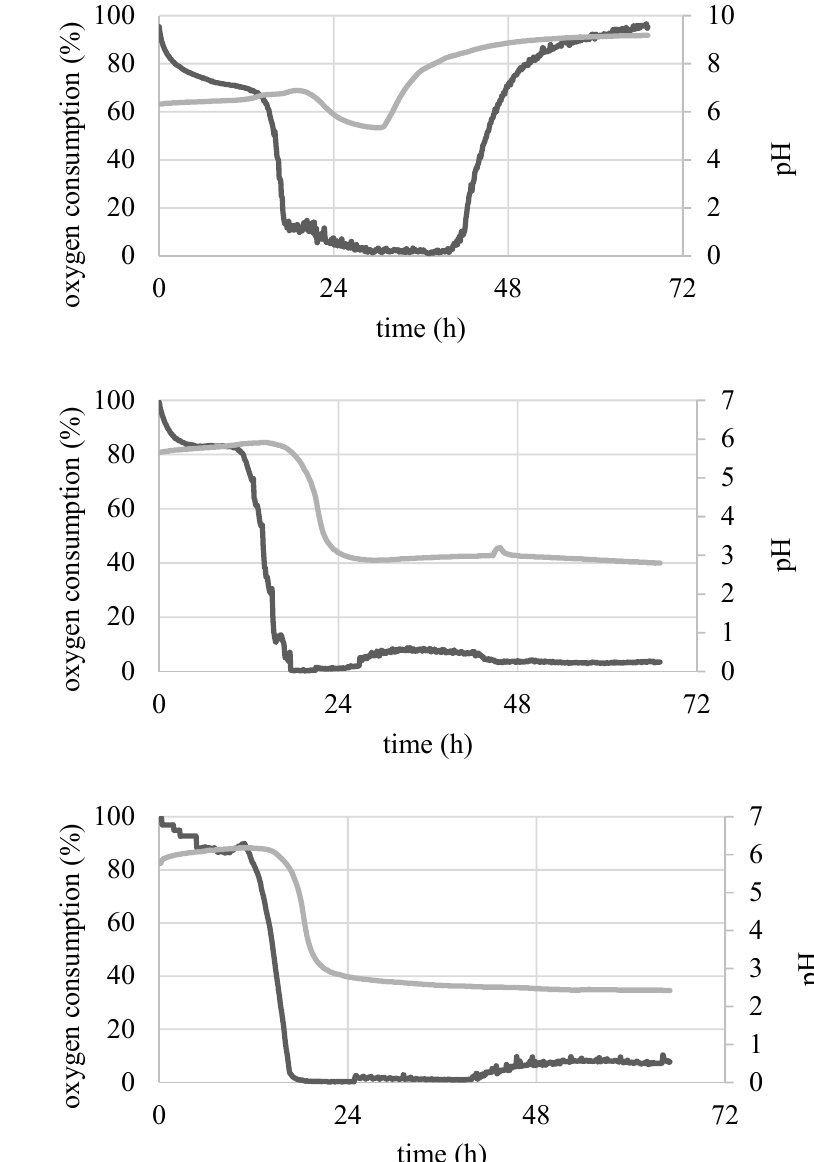
Figure 1. Changes in pH (light line) and oxygen consumption (dark line) during a batch culture of Y. lipolytica KKP 379 strain in media: ( a ) YPG, ( b ) MG7, ( c ) MO5.